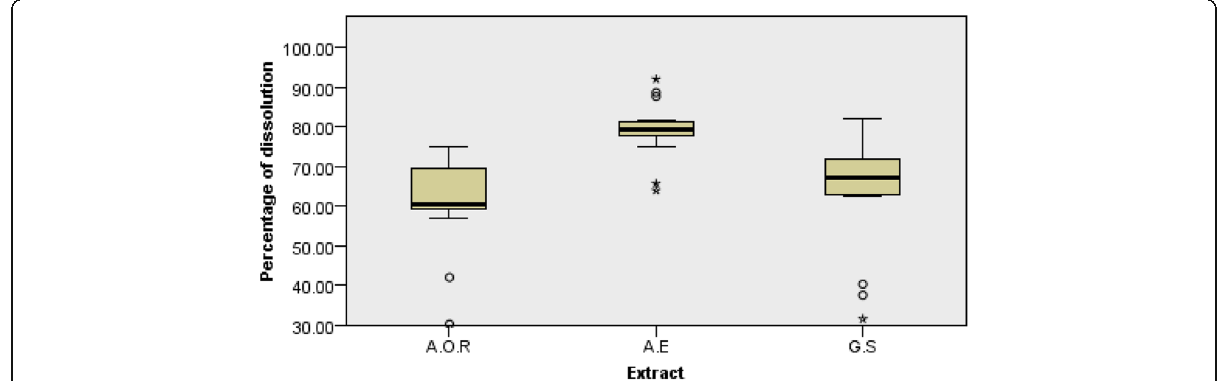
Fig. 6 Percent dissolution of clinical stone (S1, S2, S3, S4, S5) by Arnebia euchroma , Gypsophila struthium and Alcea officinalis (Root) according to extract